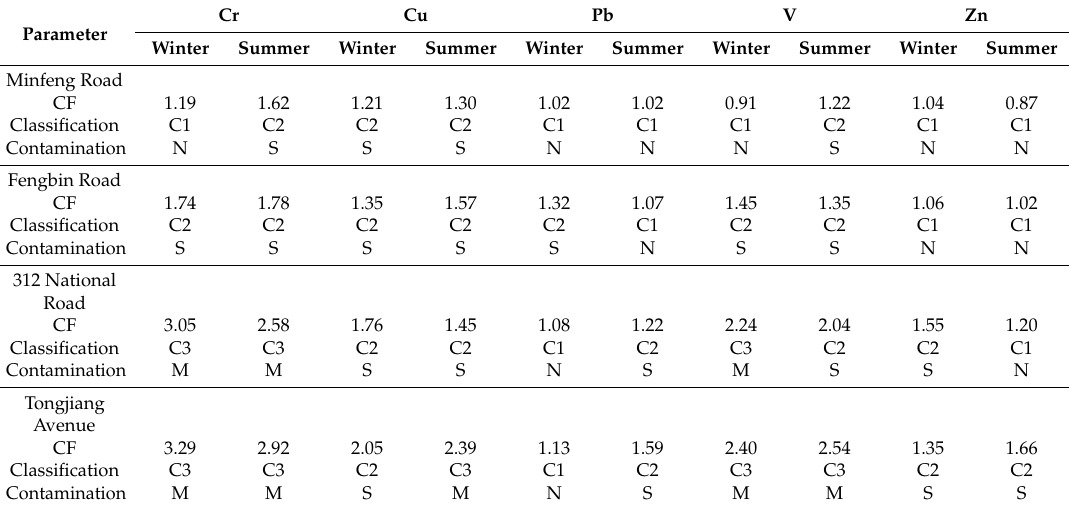
Table 2. The contamination factors (CFs) and contamination